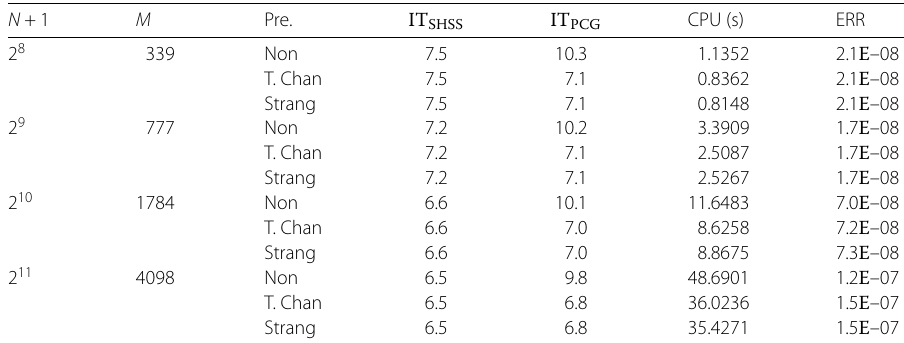
Table 1 Numerical results of the SHSS-PCG method for solving FDE ( α = 1.2) N + 1 M Pre. IT